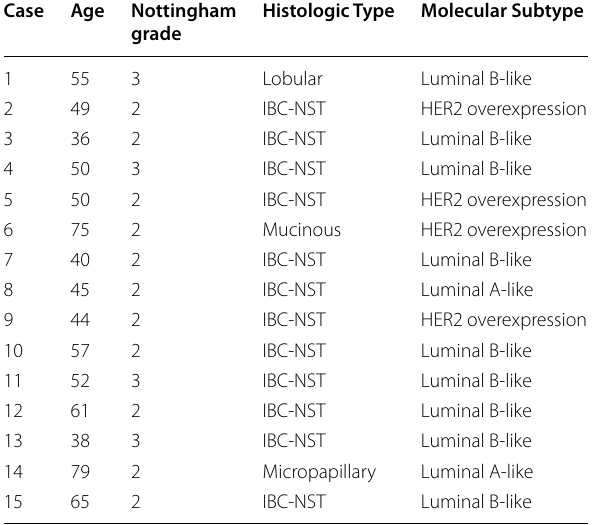
Legend: IBC-NST invasive breast carcinoma of no special type